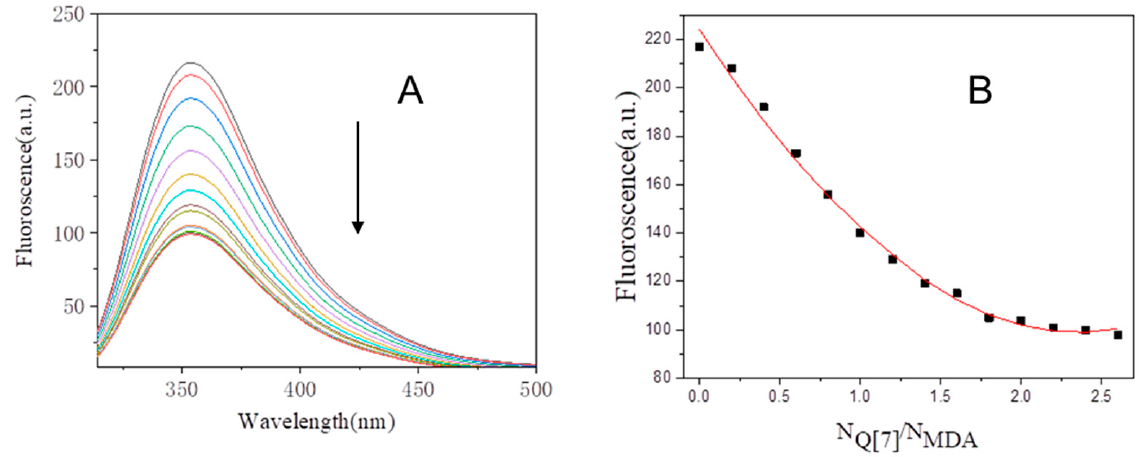
Figure 8. ( A ) The fluorescence spectroscopy of the solution of MDA with adding Q[7] at different concentrations. ( B ) The fluorescence intensity at maximum fluorescence emission wavelength corresponding to the ratio of N (Q[7]) /N (MDA) .